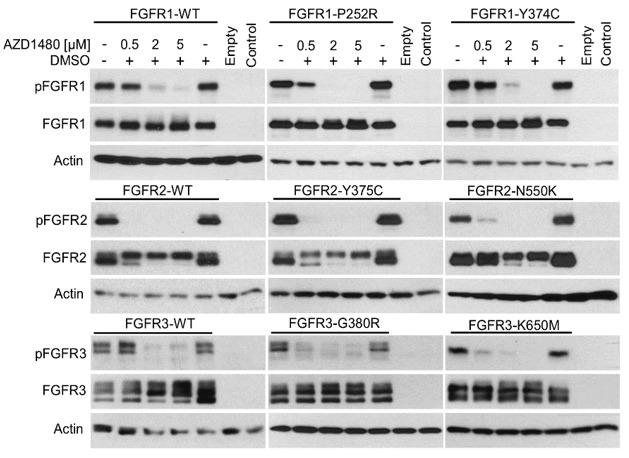
(A) 293T cells and (B) PC12 cells were transfected with pKrox24 reporters alone (293T) or together (PC12) with vector carrying Renilla luciferase under constant promoter (pRL-TK). Cells were treated with EGF (50 ng/ml) or NGF (100 ng/ml) for 24 hours before the level of Krox24 transactivation was determined by luciferase (A) or dual-luciferase (B) assay. Values are averages from four biological replicates (each measured twice) with indicated S.D. Statistically significant differences are highlighted (Student's t-test; ***p<0.001). Results are representative for three independent experiments. The levels of EGR1 induction by EGF or NGF treatment were determined by western blot. Actin serves as the loading control.